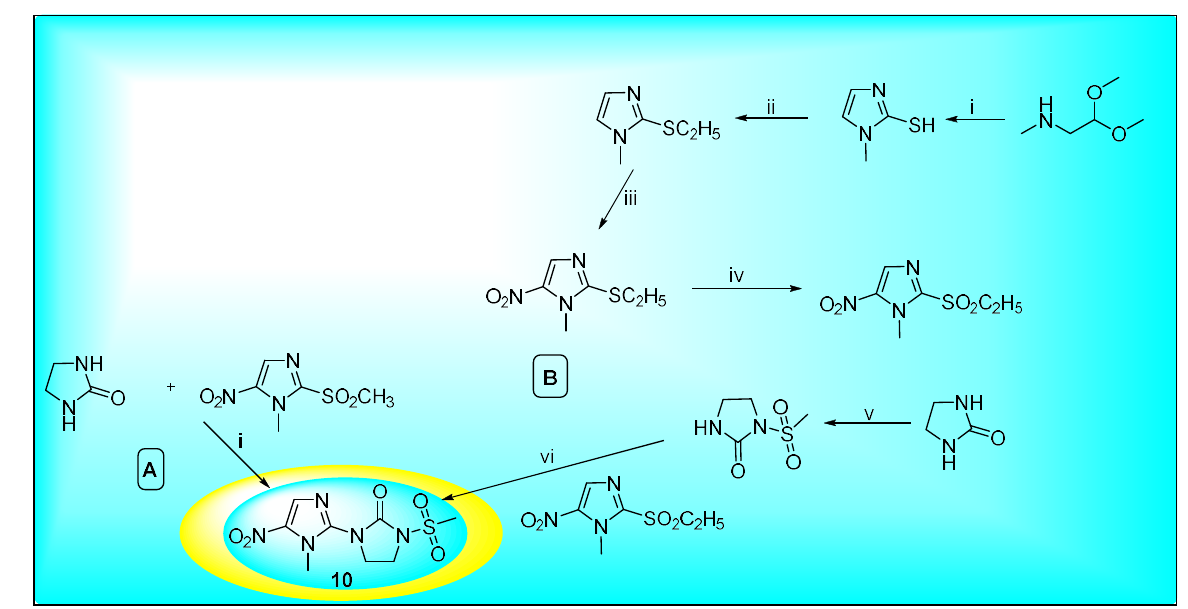
Scheme 33. Synthesis of Satranidazole 10 . Reagents and conditions: ( A ) ( i ) dry DMF, NaH, 80%; ( B )